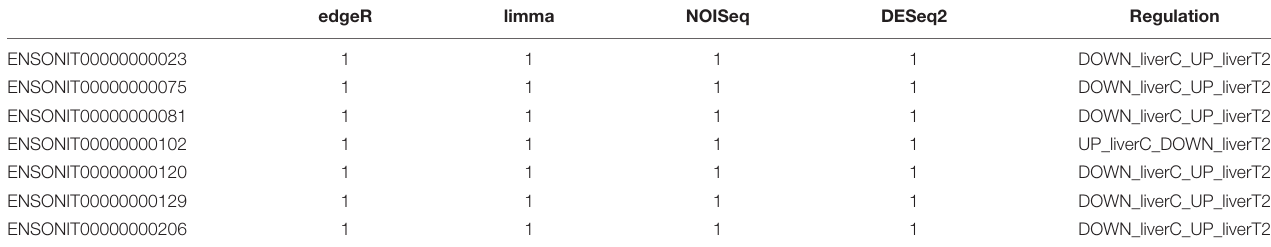
TABLE 3 | Example of intersect results table. edgeR limma NOISeq DESeq2